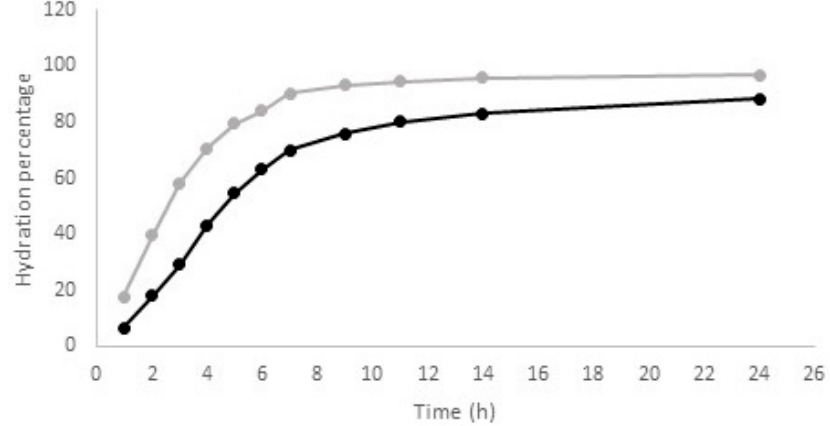
Figure 2. Water absorption curve recorded for the “ lenticchia nera from Soleto ” and the cv. Beluga (grey and black trace, respectively).